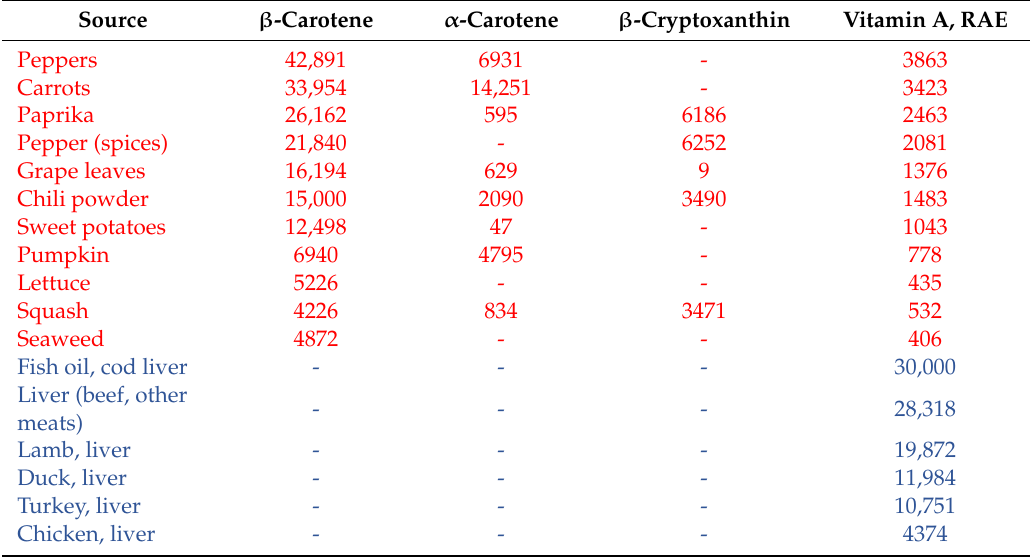
Table 1. List of food sources abundant on pro-vitamin A carotenoids (red) and retinyl esters (blue). RAE, Retinol activity equivalent. Source; USDA Food composition database. Data expressed as µ g / 100